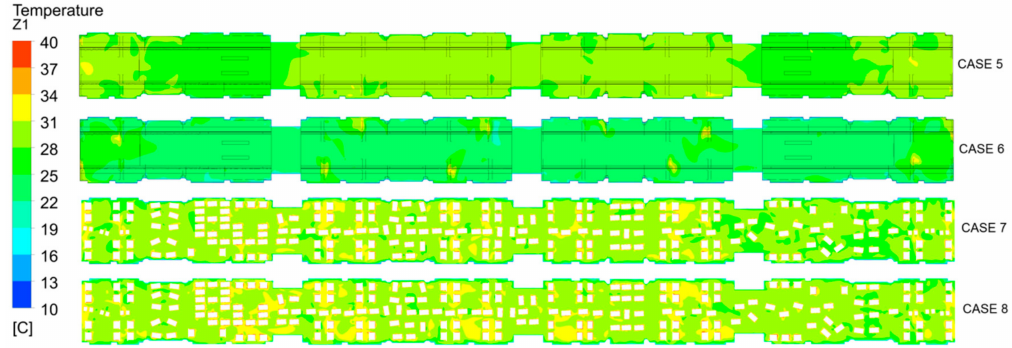
Figure 8. Temperature fields in the horizontal plane at +1.1 m, winter cases (5–8).